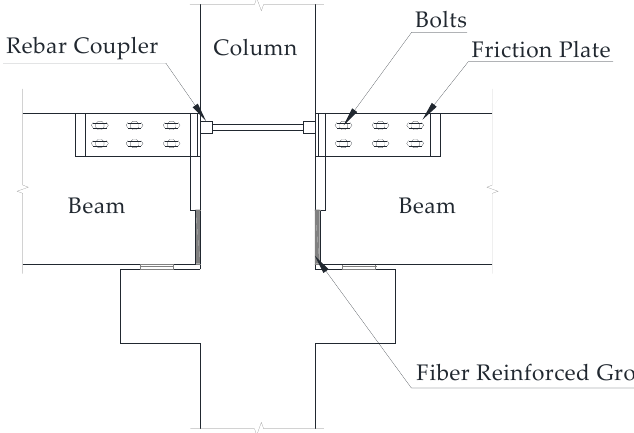
Figure 3. Example of connection with friction plates [26].